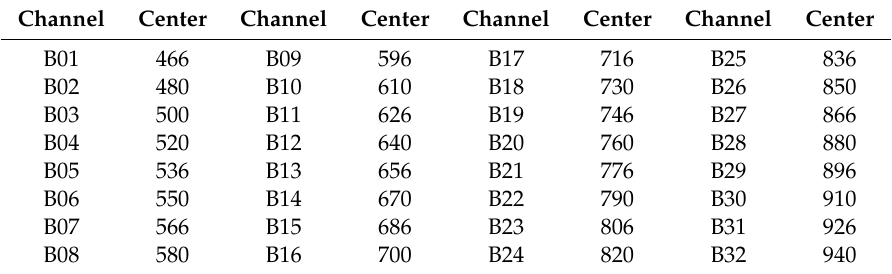
Table 1. Center wavelength of detection band of Zhuhai-1 hyperspectral imagery /